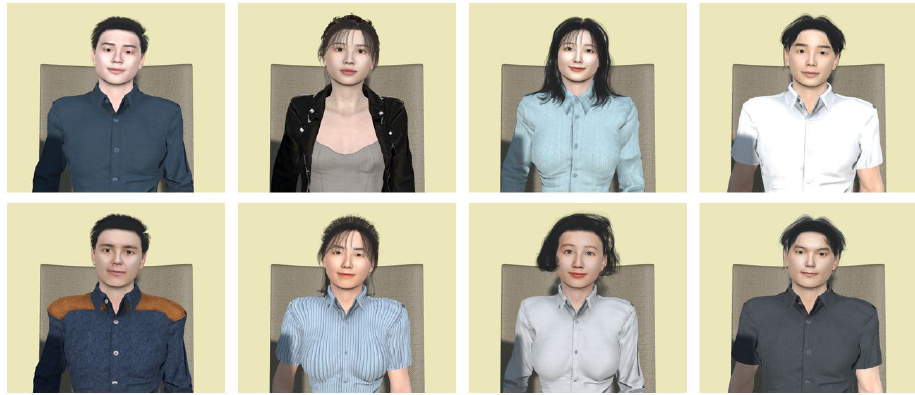
Figure 3. The 3D human models used in the studies.